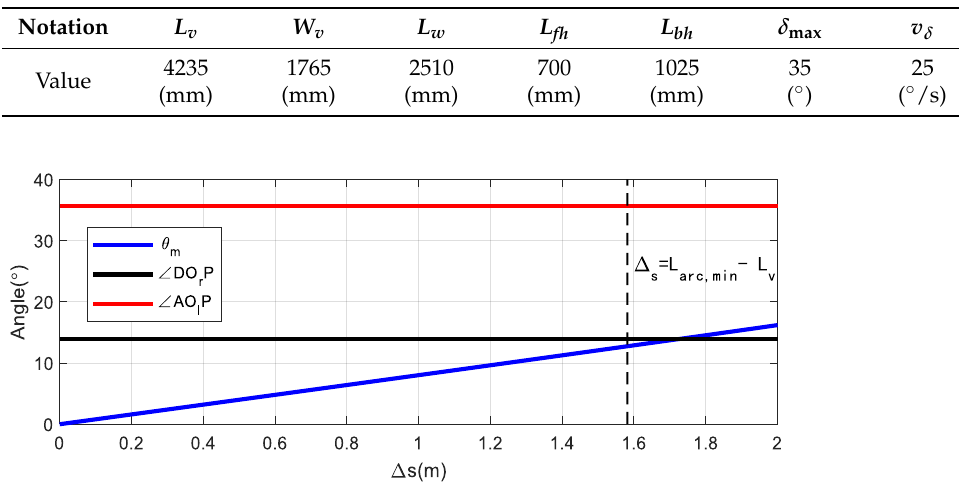
Table 1. Parameters of used vehicle model.